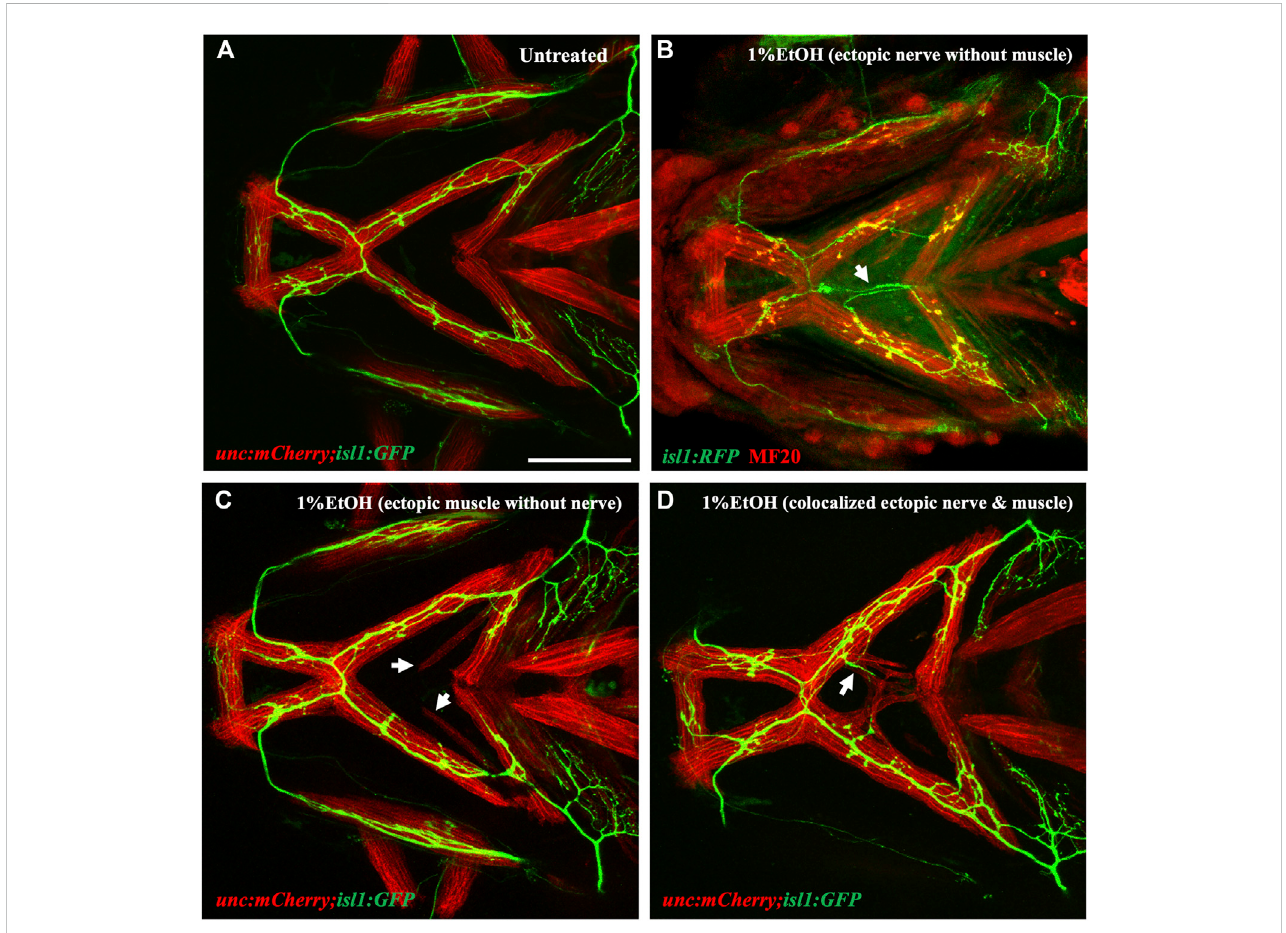
FIGURE 10 Ectopic nerve defects are independent of ectopic muscle defects (A) Untreated isl1:GFP;unc:mCherry showing muscles in red and motor nerves in green. (B) Ethanol-exposed isl1:RFP fi shimmunolabeledwithanti-RFP (ingreen)andMF20 (inred).Arrow indicatesectopic nervewithoutectopicmuscle. (C) Ethanol-exposed isl1:GFP;unc:mCherry fi sh with ectopic muscle fi bers without motor innervation. Arrows indicate ectopic muscle fi bers. (D) Ethanol- exposed isl1:GFP;unc:mCherry fi sh with coexisting ectopic nerve and ectopic muscle indicated by the arrow. Scale bar = 100